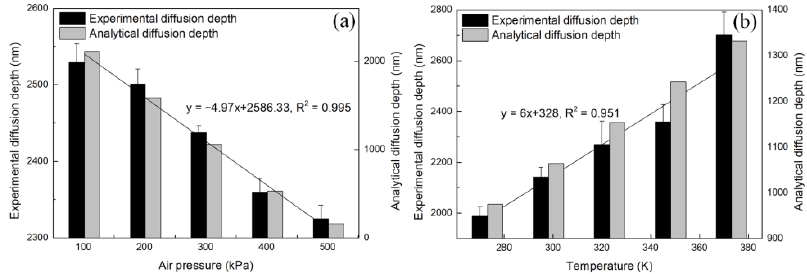
Figure 7. Experimental and analytical diffusion depths under different ( a ) air pressures and ( b ) air temperatures. ( b ) air